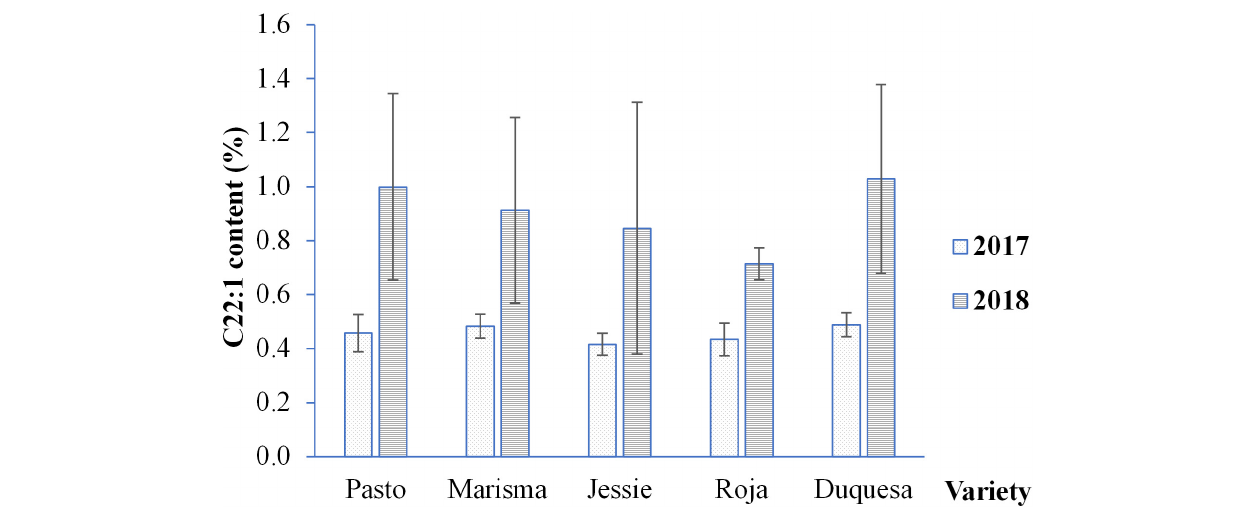
FIGURE 4 | Erucic acid (C22:1) content in quinoa seeds obtained from five varieties and 2 cultivation years (2017 and 2018). Error bars correspond to the SDs. Bars that do not share the same letters show statistically significant differences following a Welch’s ANOVA test followed by a Games–Howell post hoc test at a p -value < 0.05.